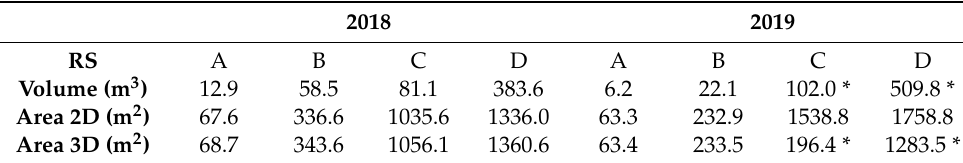
Figure 8. ( a ) Rubble spits identified in the 2018 and 2019 datasets (the striped area contains acceptable DEM vertical errors for the analysis of the rubble spits dimensions. See the vertical errors in Table 2). Background image: 2018 LiDAR DEM ( b ) RS-C and RS-D DEMs. Background image: 2018 LiDAR orthomosaic. Table 5. Characteristics of the rubble spits in 2018 and